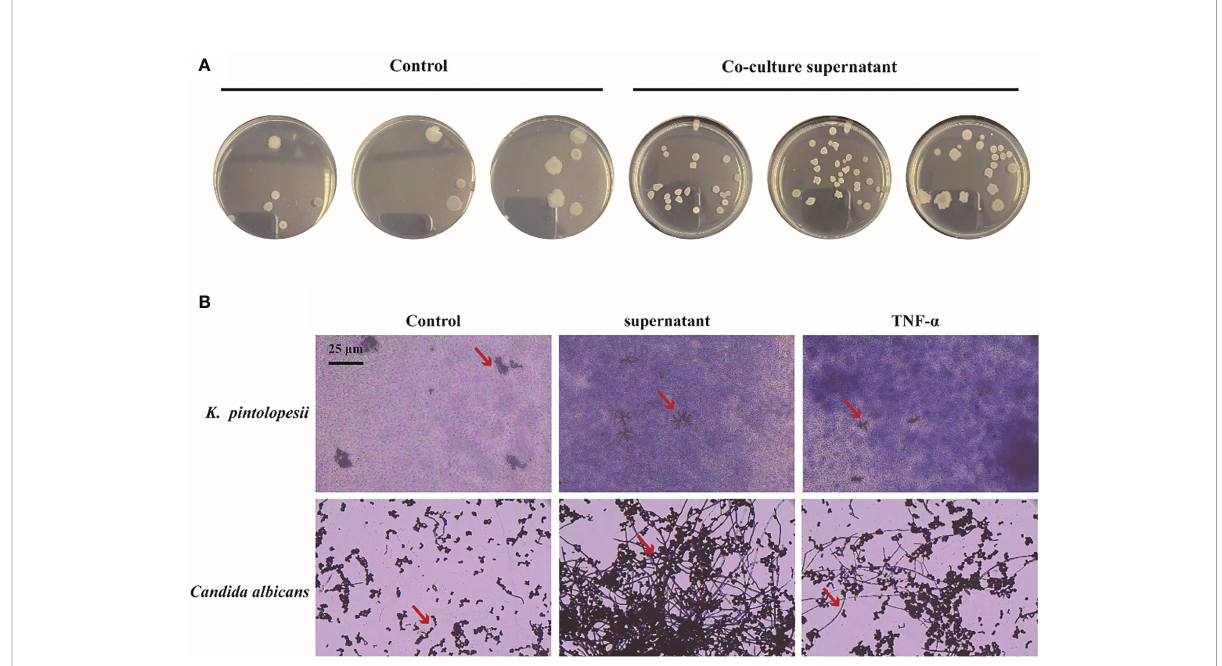
FIGURE 7 Effect of PANoptosis products on K. pintolopesii. (A) Plate count. PANoptosis products signi fi cantly promotes K. pintolopesii proliferation. (B) PANoptosis products and TNF- a (Final concentration of 1000 pg/mL) could change the morphology of K. pintolopesii and Candida albicans